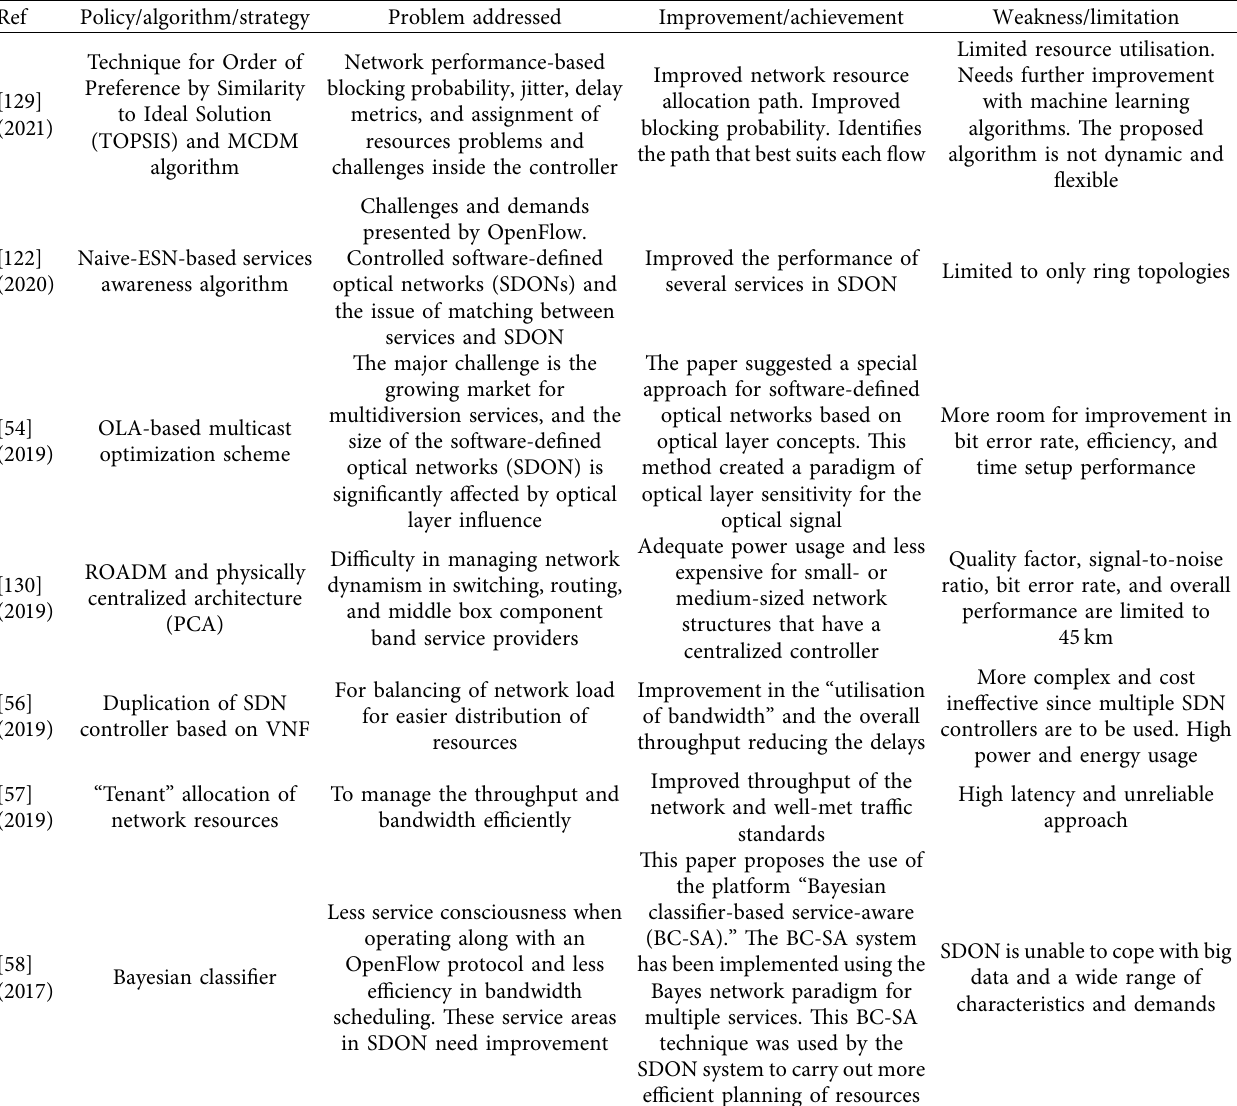
Table 10: Summary of quality-of-service solution implementation for